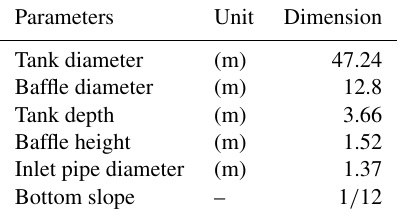
Table 1. Properties of settling tank.